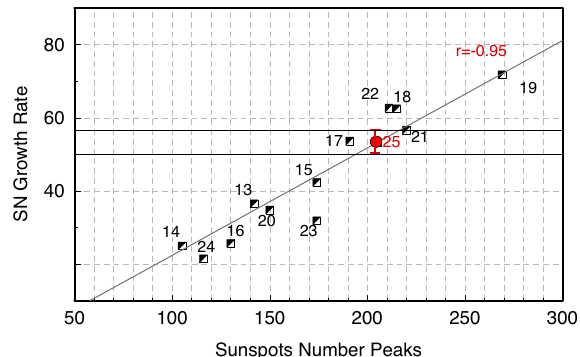
Fig. 3. Linear regression between SN growth rate and SN peaks. The growth rate forecasted for the SC 25 is 53 ± 5, thus comparable with those of SCs 17 and 21.